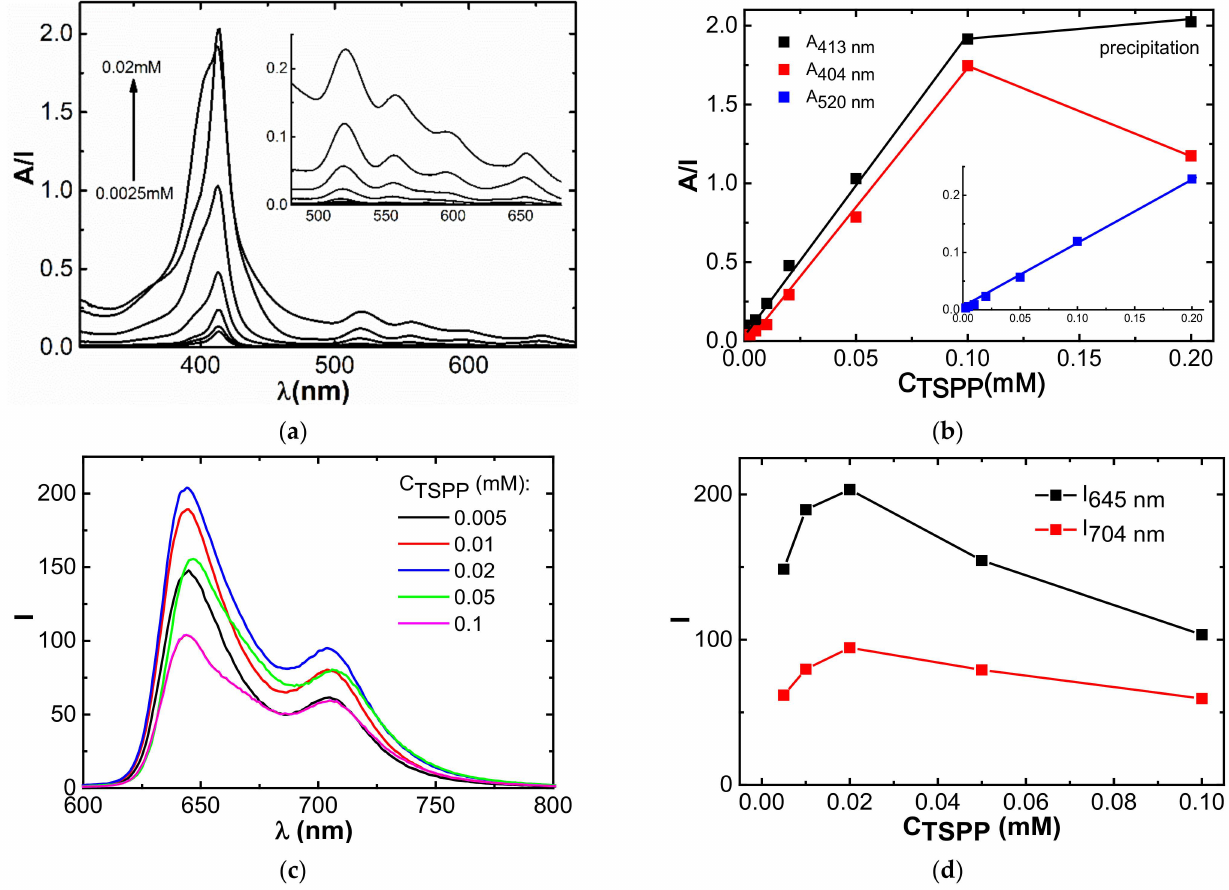
Figure 8. Absorption ( a ) and fluorescence ( c ) spectra and corresponding dependences of absorption at 404, 413, and 520 nm ( b ) and fluorescence intensity at 655, 704 nm ( d ) versus concentration of TSPP:LaSurf = 1:1 mixture. The insets detail changes of UV spectra of Q bands ( a ) and concentration dependence of absorption at 520 nm in TSPP:LaSurf = 1:1 mixture ( b